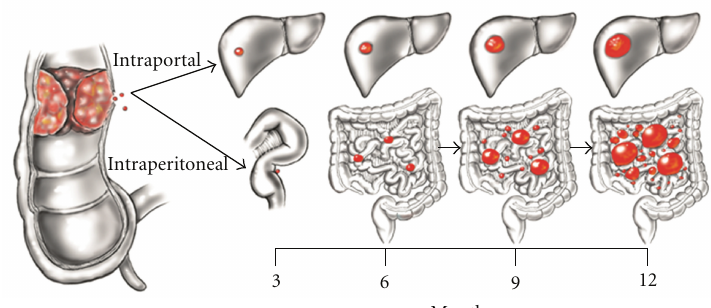
Figure 3: Schematic diagram that presents a theoretical model comparing the progression of one colorectal liver metastasis to one peritoneal metastases over one year. The liver metastasis will expand within the liver parenchyma with a doubling time of approximately three months. The peritoneal metastasis will progress at approximately the same speed but will also exfoliate cancer cells into the free peritoneal space. Many cancer nodules of many di ff erent sizes will occur widely distributed throughout the abdomen and pelvis within one